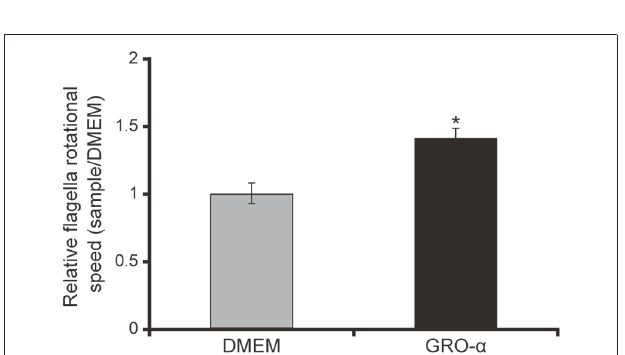
FIGURE 7 | GRO- α facilitates a swarming motility of the P. aeruginosa PAO1 strain. (A) The P. aeruginosa PAO1 strain was spotted on swarming agar containing growth regulated oncogene - α or Dulbecco’s modified Eagle medium (DMEM; control). After incubation for 14 h, the swarming agar plate was observed and photographed. (B) The radial distance (mm) from the center of the agar was measured. Error bars indicate standard error ( n = 3). * P < 0.05 compared with DMEM.